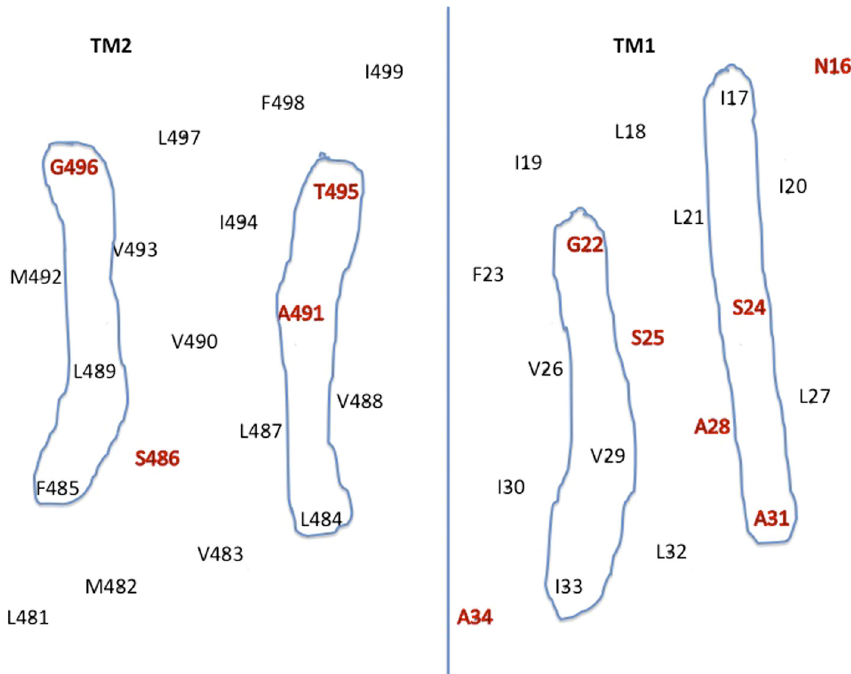
Figure 4 . Helical net diagrams (40) of TM1 and TM2. The transmembrane domains are shown with the extracellular surface at the bot- tom and the cytoplasmic surface at the top of the fi gure. The residues colored red have helix packing values larger than that of Gln (38). The residues grouped by blue lines in TM1 and TM2 correspond to those in Figure 3 indicated by the red arrows suggesting helical packing